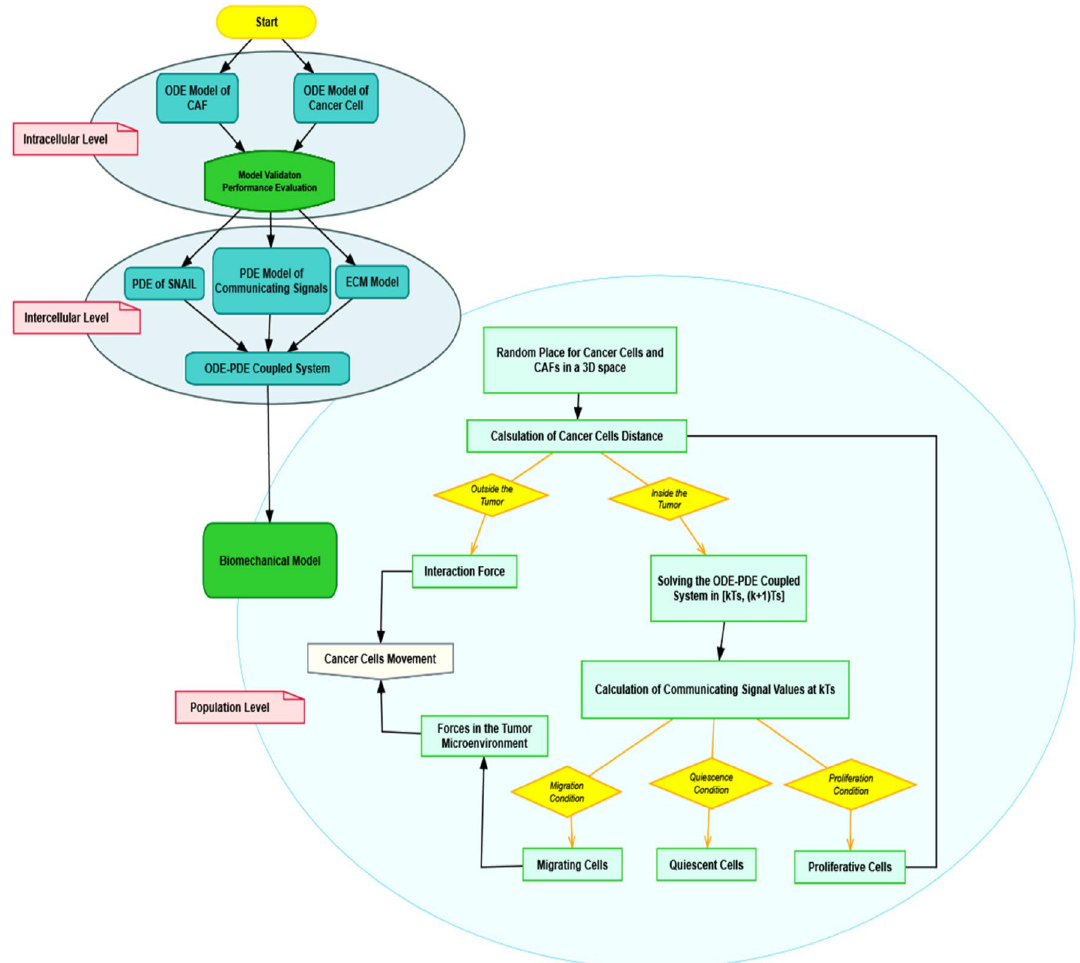
Figure 1. Flowchart of necessary steps in each level of multiscale model of cancer cell